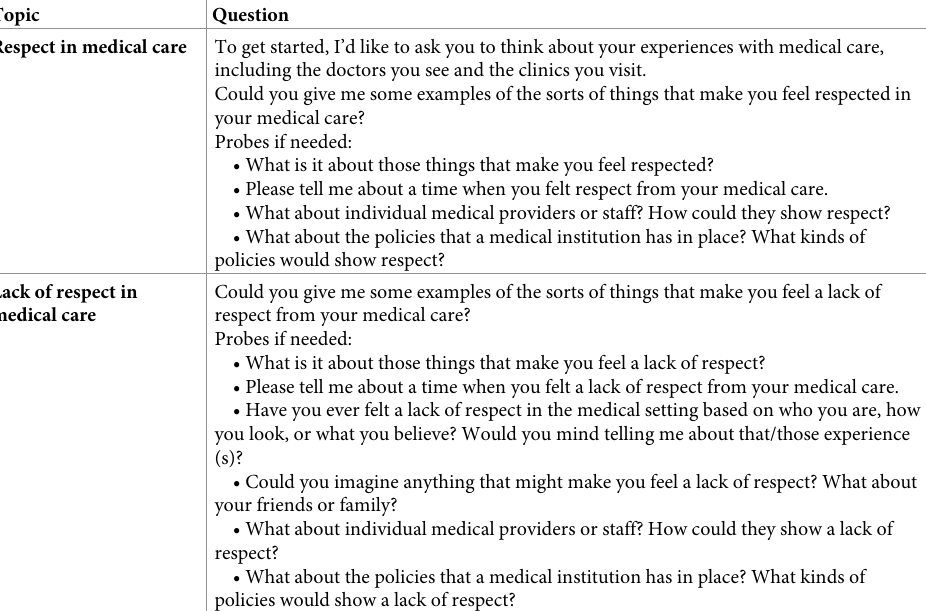
Table 1. Interview questions about respect in